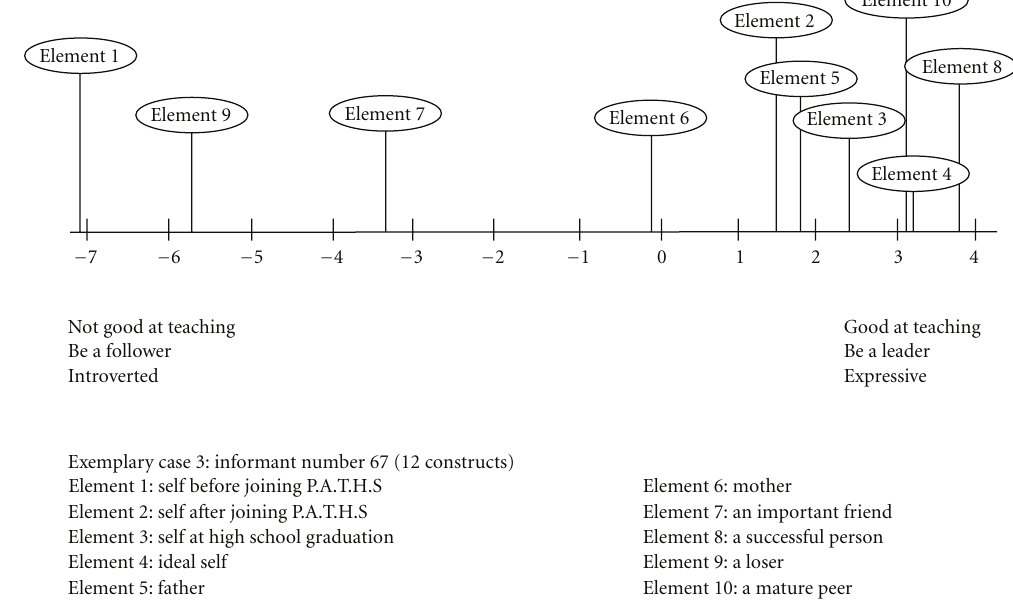
Figure 3: Line graph showing the mental representation of di ff erent roles for case